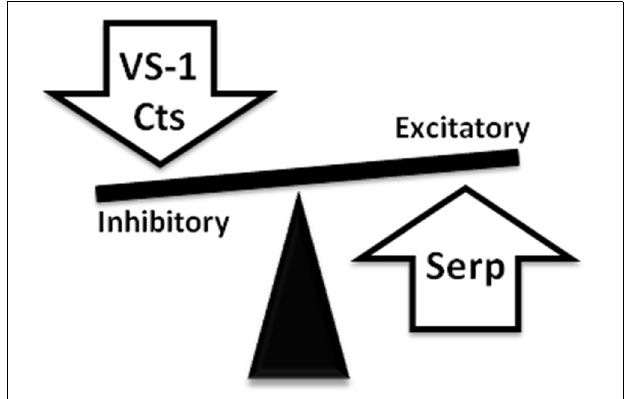
FIGURE 4 | Representative picture showing the ability of CgA-derived peptides to reset cardio-circulatory homeostasis through “whip-brake” networks in response to perturbed conditions. A tissue-specific and spatio-temporally concerted processing of CGA can generate counter-regulatory peptides able to reset cardio-circulatory homeostasis through “whip-brake” networks.